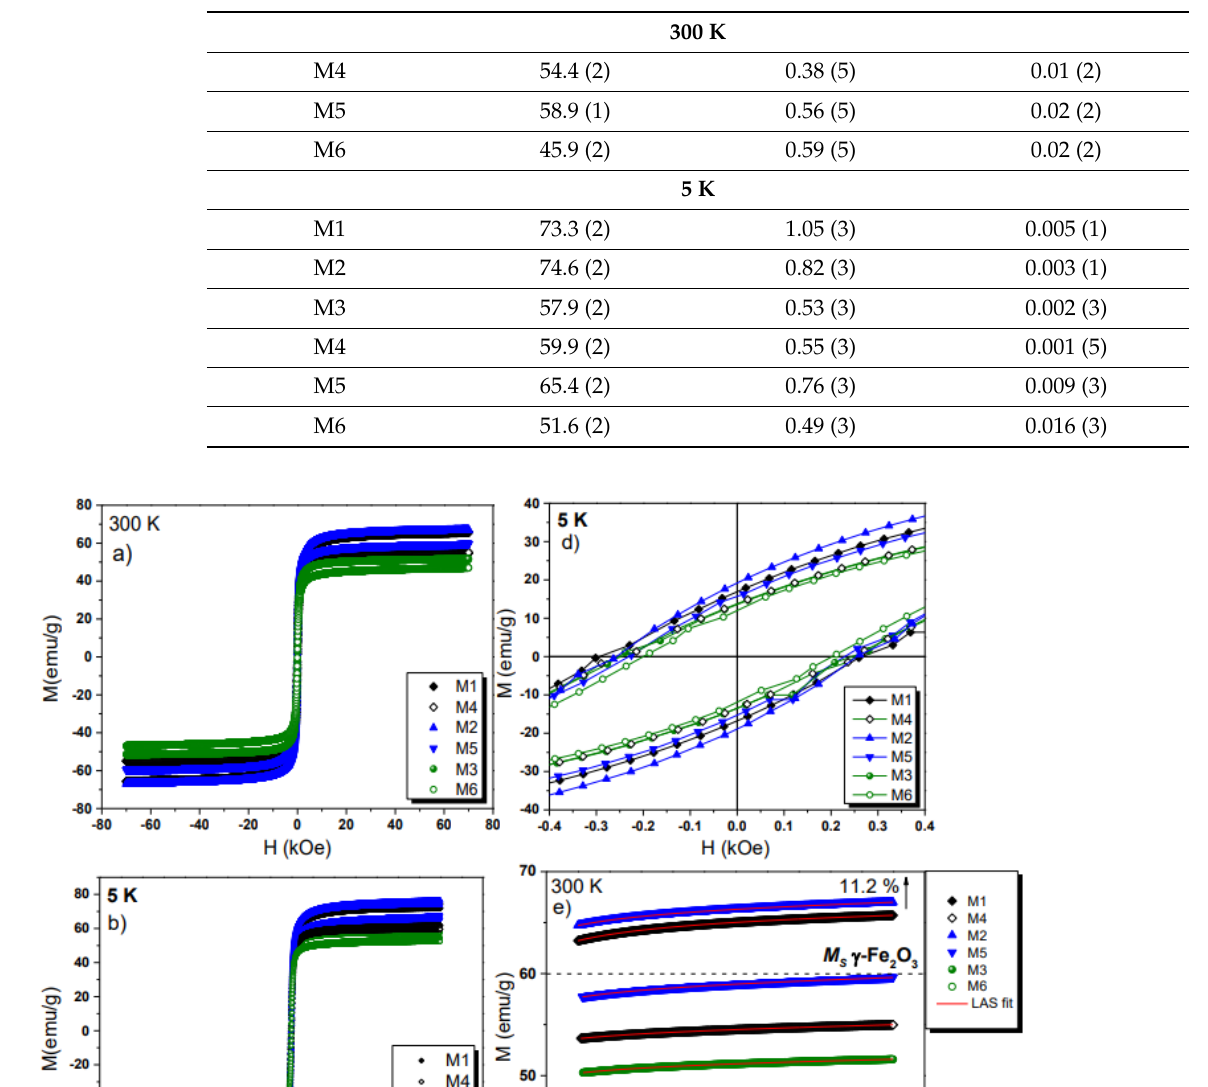
Six samples of γ -Fe 2 O 3 NPs functionalized with sodium polystyrene sulfonate (nano